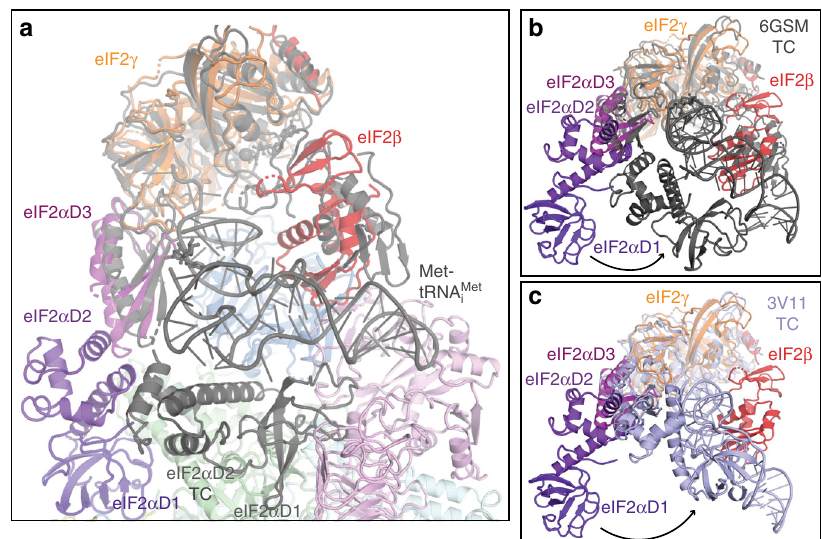
Fig. 5 Superposition of the TC with eIF2B – eIF2( α P) complex based on eIF2 γ . a Superposition of yeast TC (6GSM) in grey with the model of eIF2B – eIF2( α P) complex in map C showing that Met-tRNA i Met can bind without clash to eIF2 γ and eIF2 α - D3 while eIF2 α -D1 is still attached to eIF2B. b Same superposition as in a in a different orientation shows the large conformational changes that eIF2 α – D1 and D2 undergo when bound to eIF2B or Met-tRNA i Met both competing for eIF2 α . c Same as in b , but superimposed with S . solfataricus TC (3V11, light